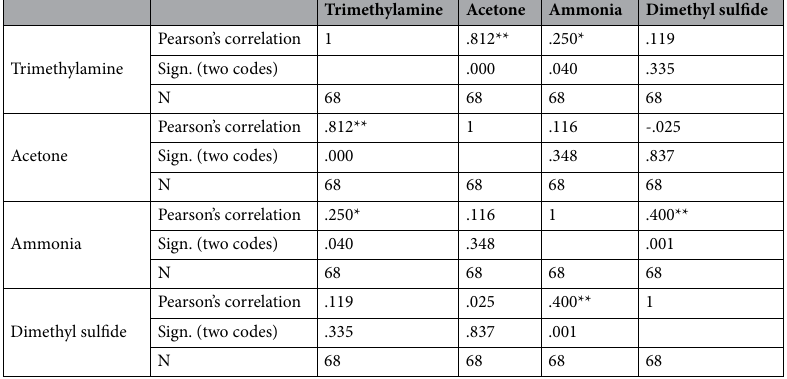
Table 4. Independent test with Pearson’s correlation. **The correlation is significative at level 0, 01 (two codes). *The correlation is significative at levels 0, 05 and 0, 01 (a two codes).